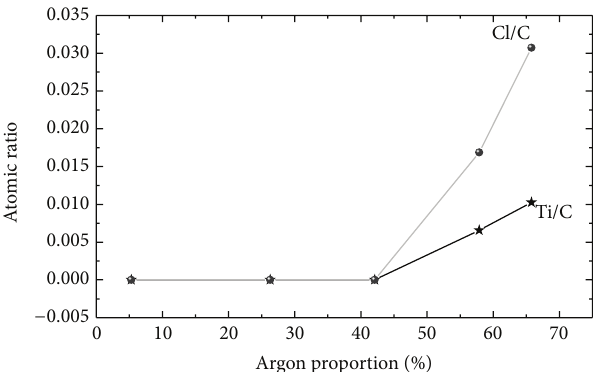
Figure 3: Cl/C and Ti/C atomic ratios in the films as a function of the argon proportion in the gas